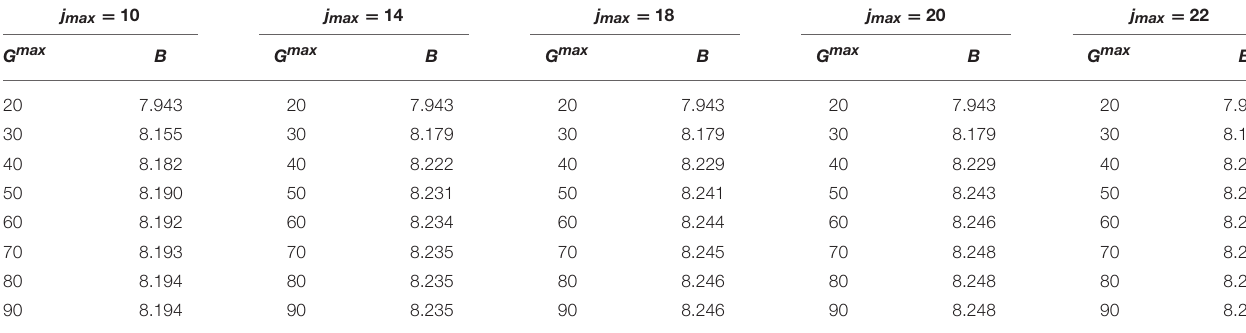
TABLE 5 | Same as Table 2 but for the Malfliet-Tjon potential model [14].